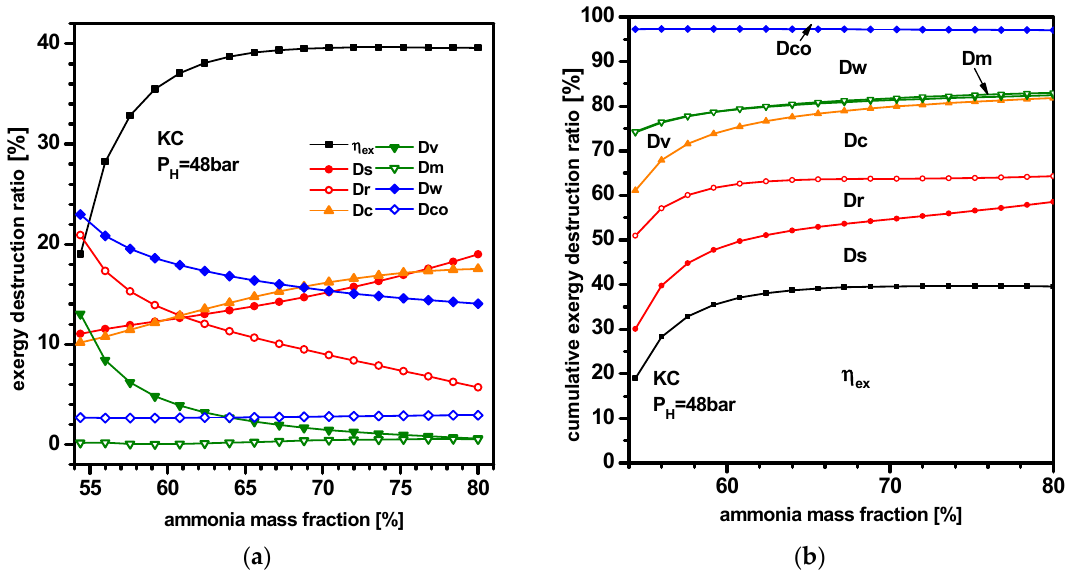
Figure 12. Dependence of ( a ) separate and ( b ) cumulative ratios of exergy consumption on the ammonia mass fraction for P H = 48 bar in the KC.